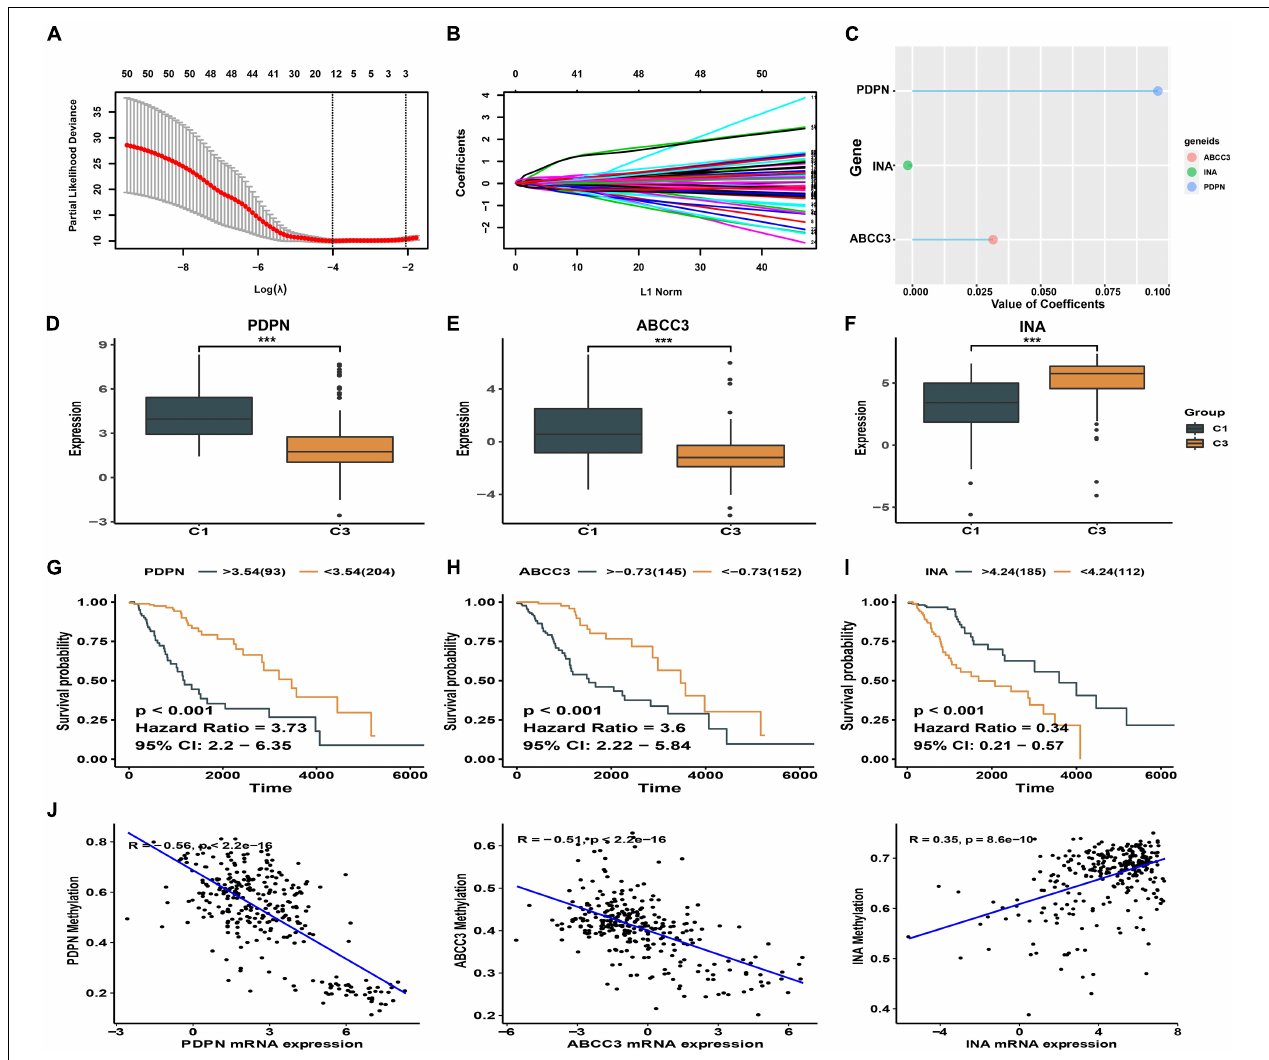
FIGURE 3 | Identification of signature genes. (A) The cross-validation plot of LASSO regression [the dashed lines signify the optimal log ( λ ) value]. (B) LASSO coefficients of 51 DEGs with independent prognostic value. (C) LASSO coefficients of the signature genes. (D–F) Expression difference of ABCC3, PDPN, INA between high and low immune score groups. (G–I) Kaplan-Meier plot showing different prognosis based on the differential expression of ABCC3, PDPN, and INA. (J) Correlation between DNA methylation and signature genes expression. *** p < 0.001.